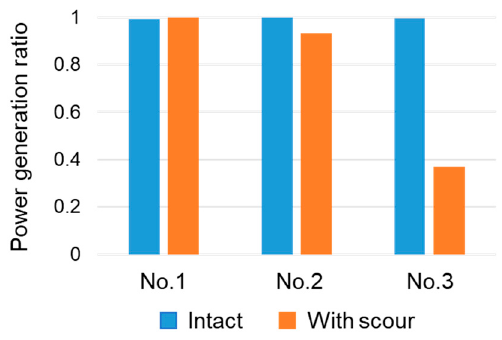
Figure 14. Power generation in the y-direction, 3rd mode.